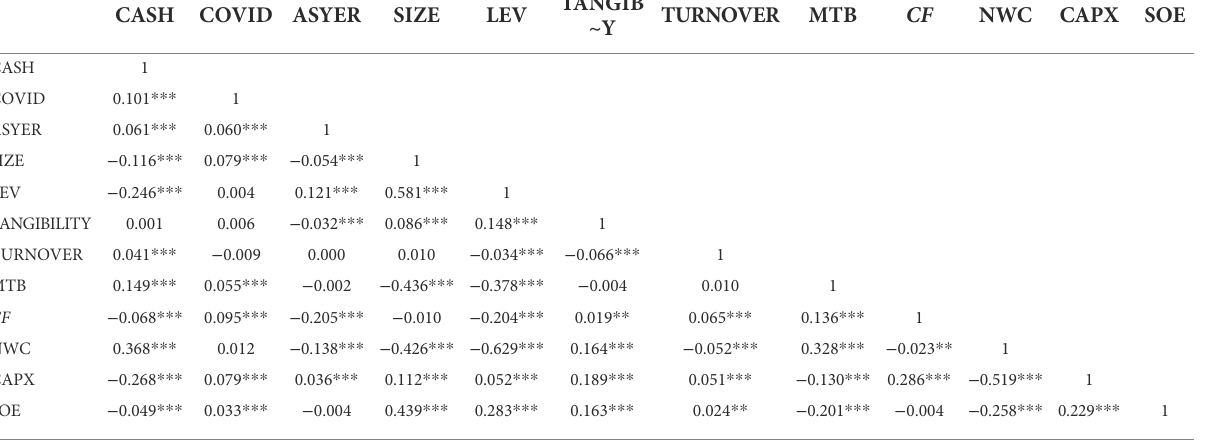
TABLE 3 Correlation matrix.